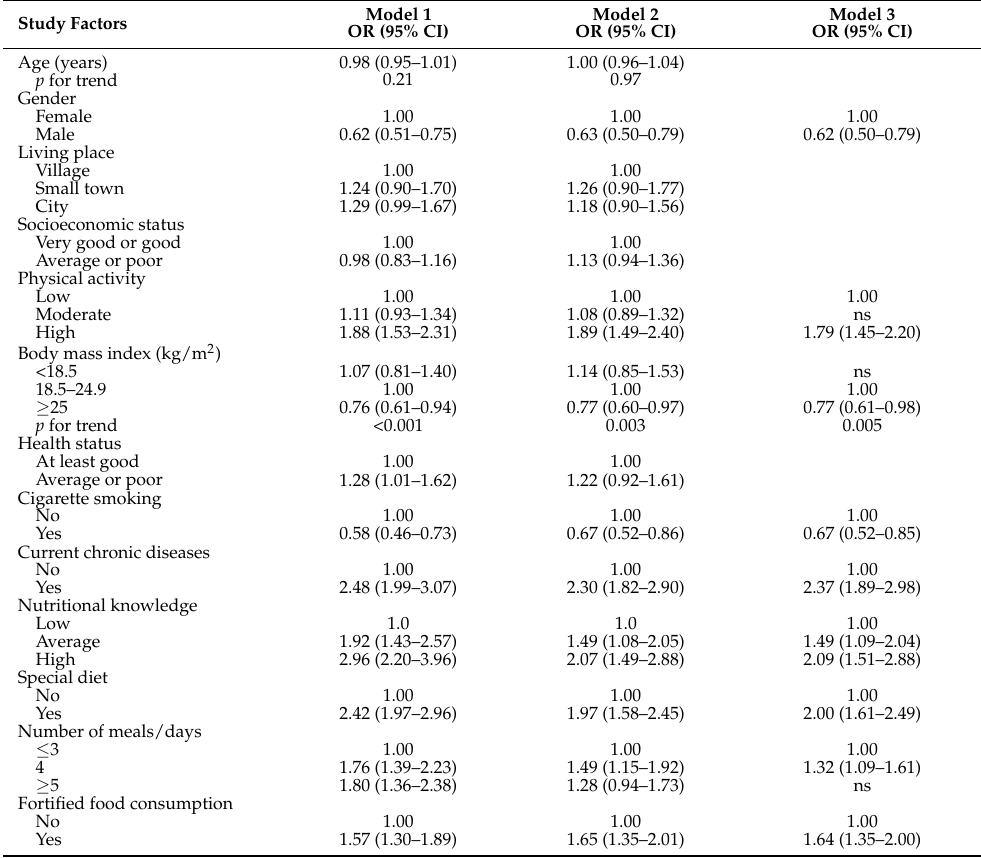
Table 3. The logistic regression of dietary supplement use by socio-demographic and lifestyle determinants in university students (n =